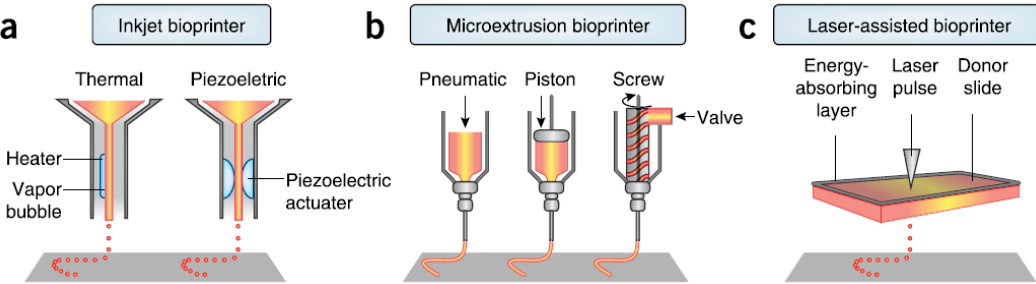
Figure 2. Schematic diagram of ( a ) thermal inkjet printers electrically heating the printhead to produce air-pressure pulses that force droplets from the nozzle, whereas acoustic printers using pulses formed by ultrasound pressure from piezoelectric element; ( b ) microextrusion printers using pneumatic or mechanical (piston or screw) dispensing systems to extrude bioink beads; and ( c ) laser-assisted printers utilizing focused laser beams on an absorbing substrate to propel bioink onto a collector substrate, courtesy of [24].